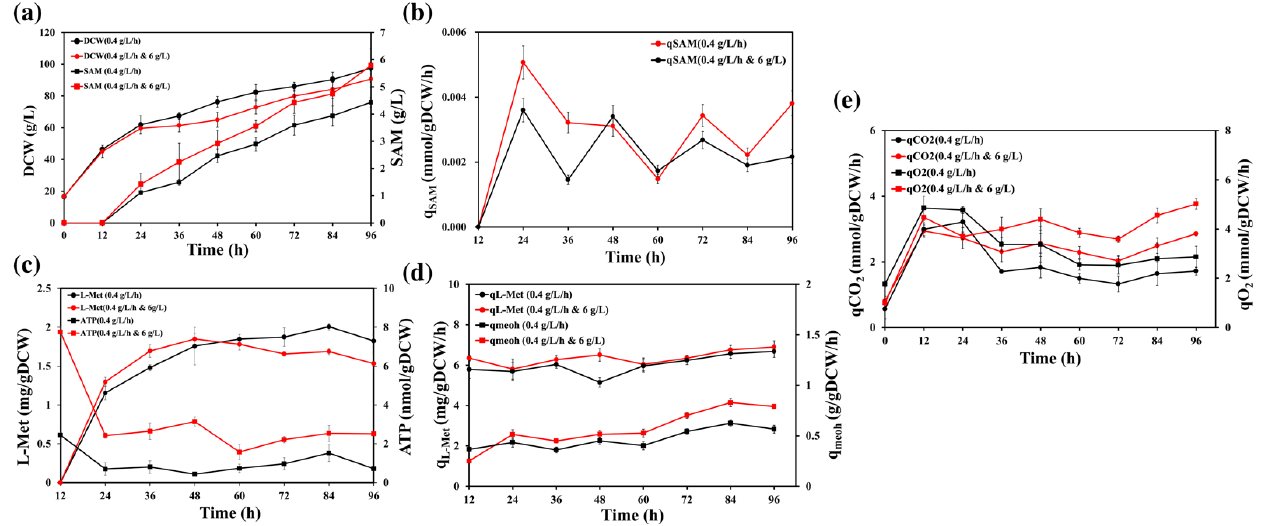
Figure 2. Physiological profiles of P. pastoris fermentation under supplementation with sodium citrate. The parameters include ( a ) biomass and SAM amounts, ( b ) specific SAM production rate, ( c ) L-methionine and ATP concentrations, ( d ) specific L-methionine and methanol uptake rate, ( e ) spe- cific CO 2 emission rate and specific O 2 uptake rate. All parameters were measured based on at least triplicate measurements. The experiments were run in triplicates. The L − Met and ATP concentra- tions described in the figure are statistically significant.